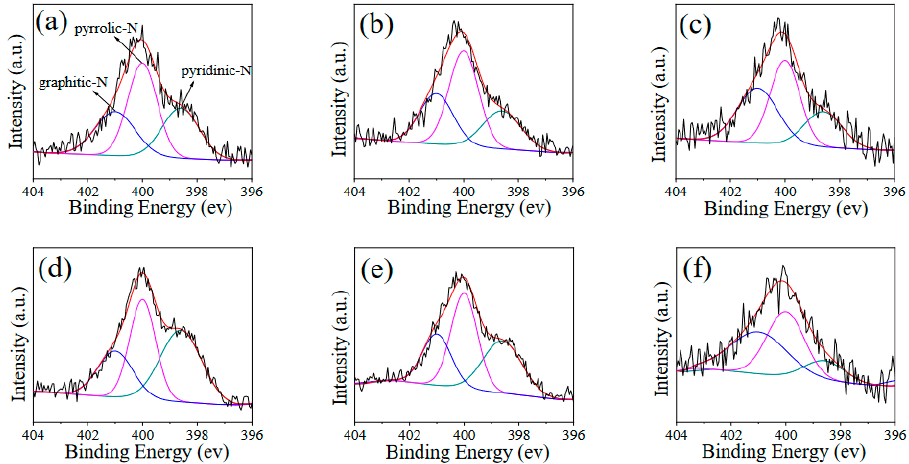
Figure 5. XPS wide scan of the L-CN-600 sample.